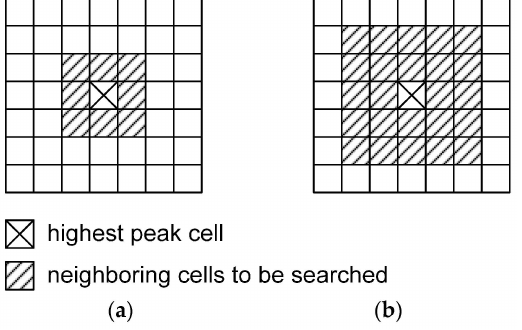
Figure 11. Searching of the neighboring cells in ( a ) the 1st iteration and ( b ) 2nd